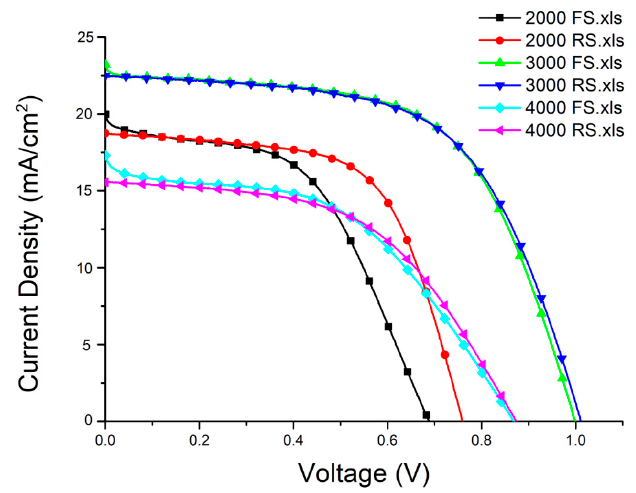
Figure 10. The J – V curves from reverse scan (RS) and forward scan (FS) for the PSC devices based on TiO 2 /SnO 2 complementary composite hole blocking layer under different SnO 2 spin-coating speeds, measured under simulated sunlight with intensity of 100 mW cm − 2 (AM 1.5 G).